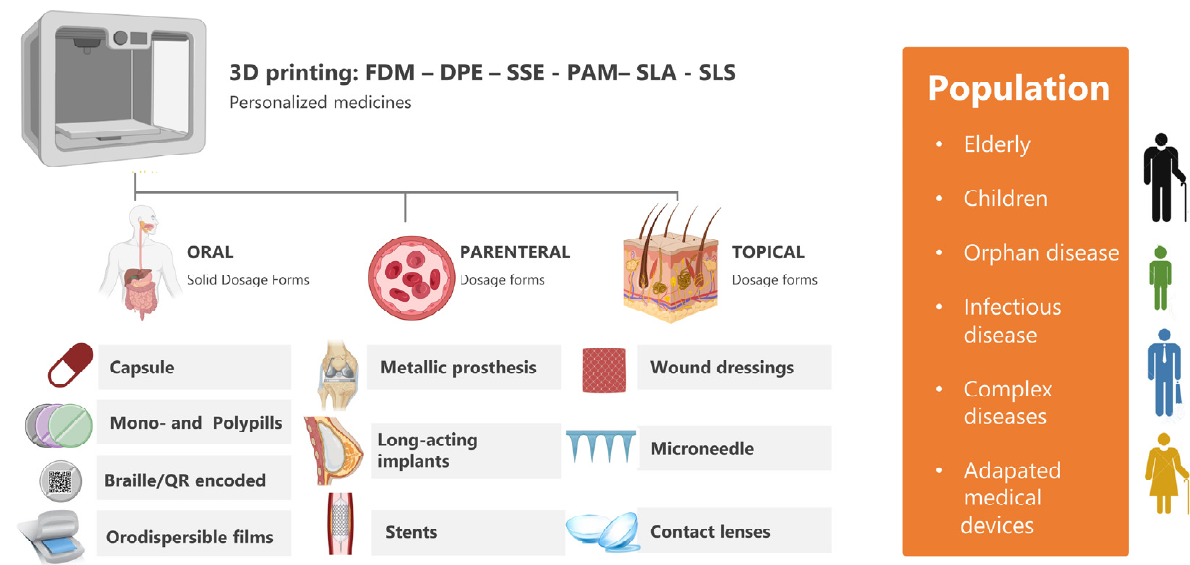
Figure 5. Application of 3D printing technologies to manufacture personalized medicines.